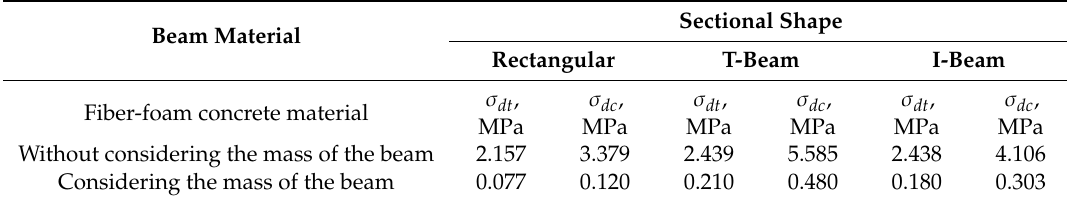
Table 3. Maximum dynamic stresses in beams of rectangular, T- and I-shape, considering bimodularity